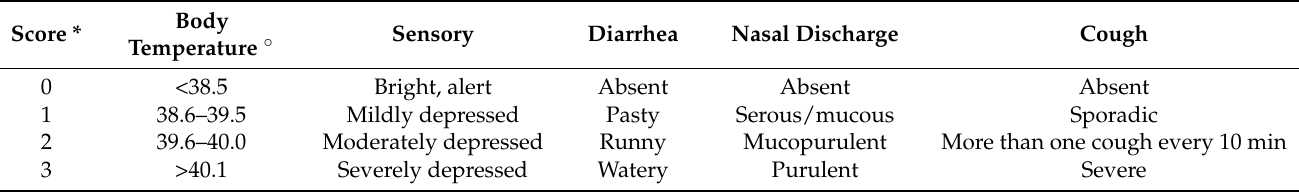
Table 1. Clinical scoring system. The score from each symptom was added to give a daily clinical score. Score